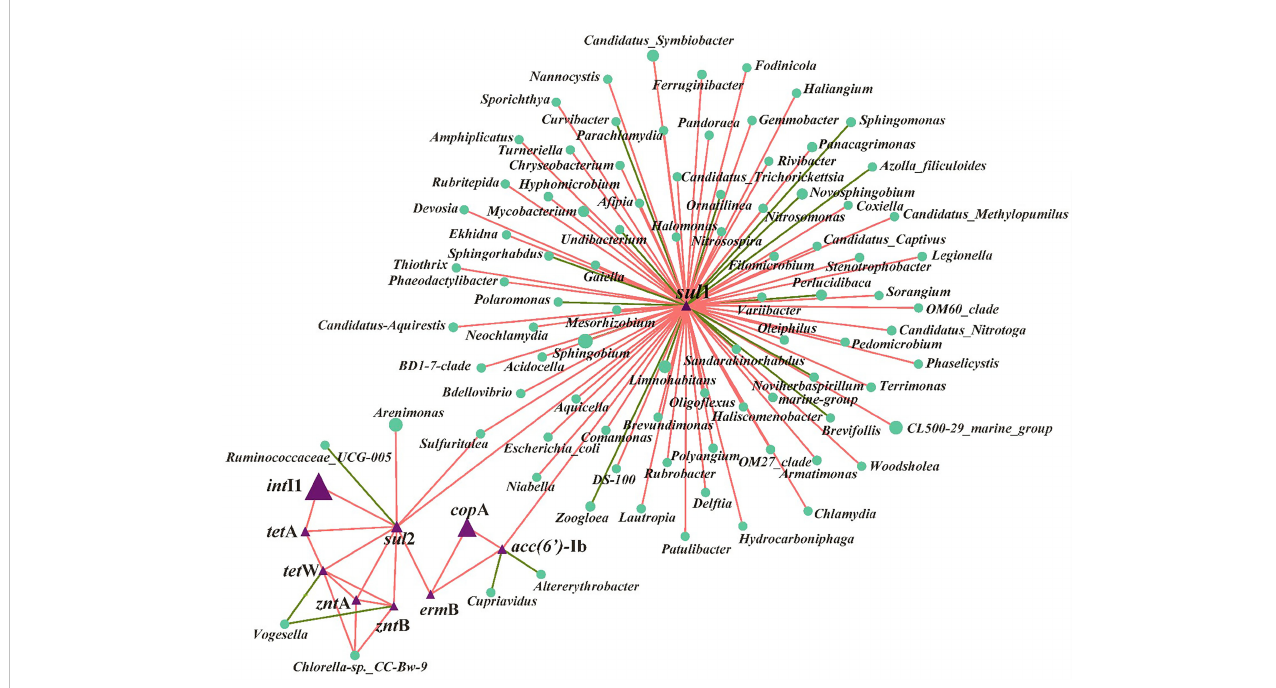
FIGURE 4 Network analysis based on Spearman correlation analysis among ARGs, MGEs, MRGs and their potential host bacteria in all the samples. The connection between two nodes represents a signi fi cant positive correlation ( P < 0.05), the red color means positive correlation and green color means negative